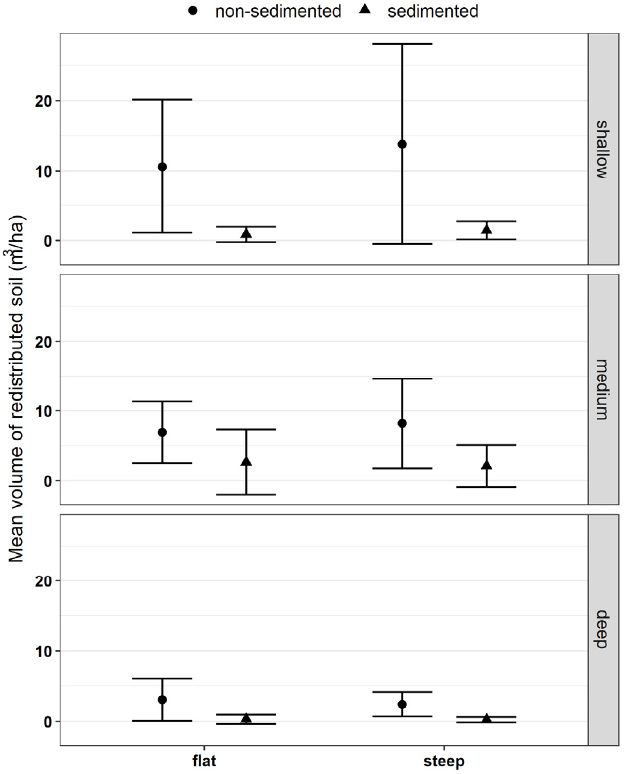
Figure 3. Mean volume of redistributed soil (m 3 /ha) by wild boar rooting of various depths (shallow: <10 cm, medium: 10–30 cm, and deep: >30 cm) during a monthly period on sedimented or non- sedimented soil, and flat or steep areas.